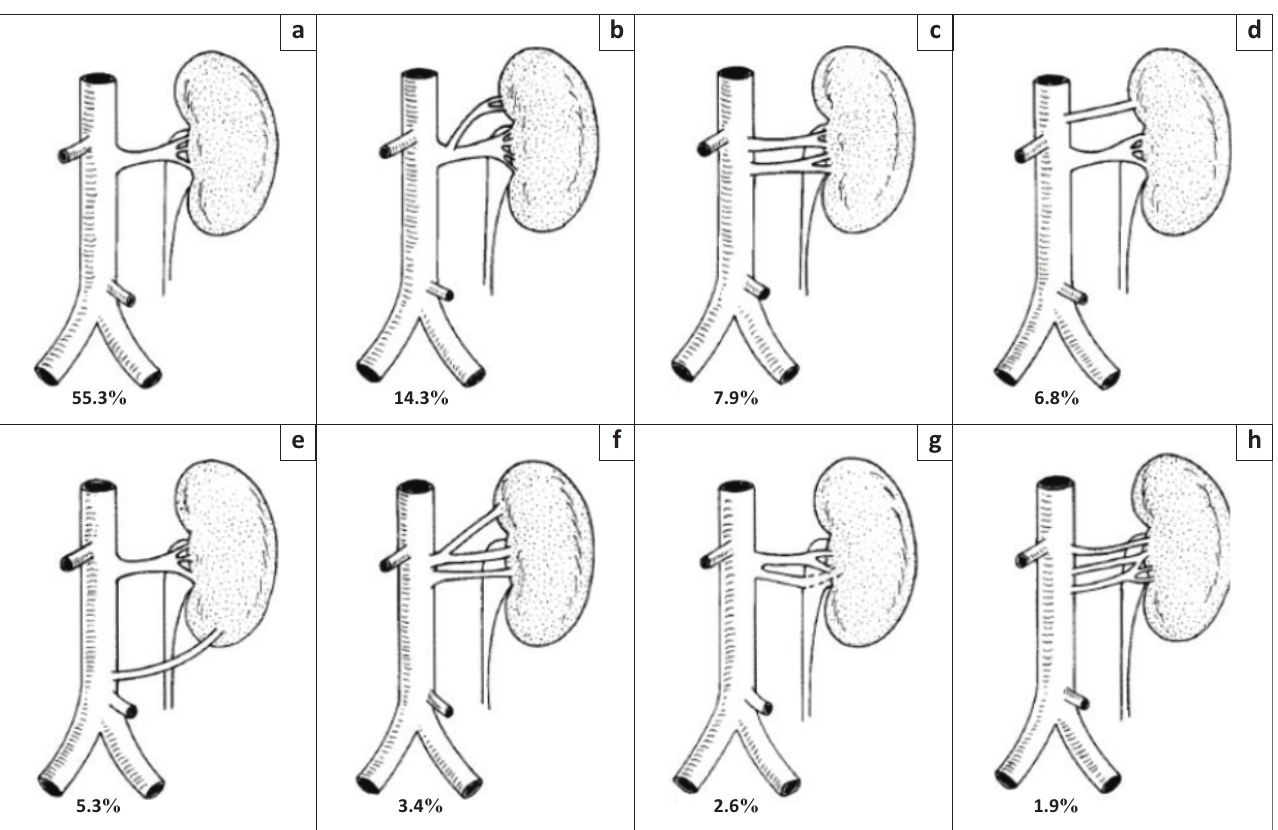
FIGURE 4: Variations in renal arteries: (a) type 1a – 1 hilar artery, (b) type 1b – 1 hilar with 1 superior pole extra-hilar branch, (c) type 1c – 2 hilar arteries, (d) type 1d – 1 hilar with 1 superior polar artery, (e) type 2a – 1 hilar with 1 inferior polar artery, (f) type 2b – 2 hilar arteries with 1 superior pole extrahilar branch, (g) type 2c – 1 hilar with a precocious bifurcation, and (h) type 2d – 3 hilar arteries.